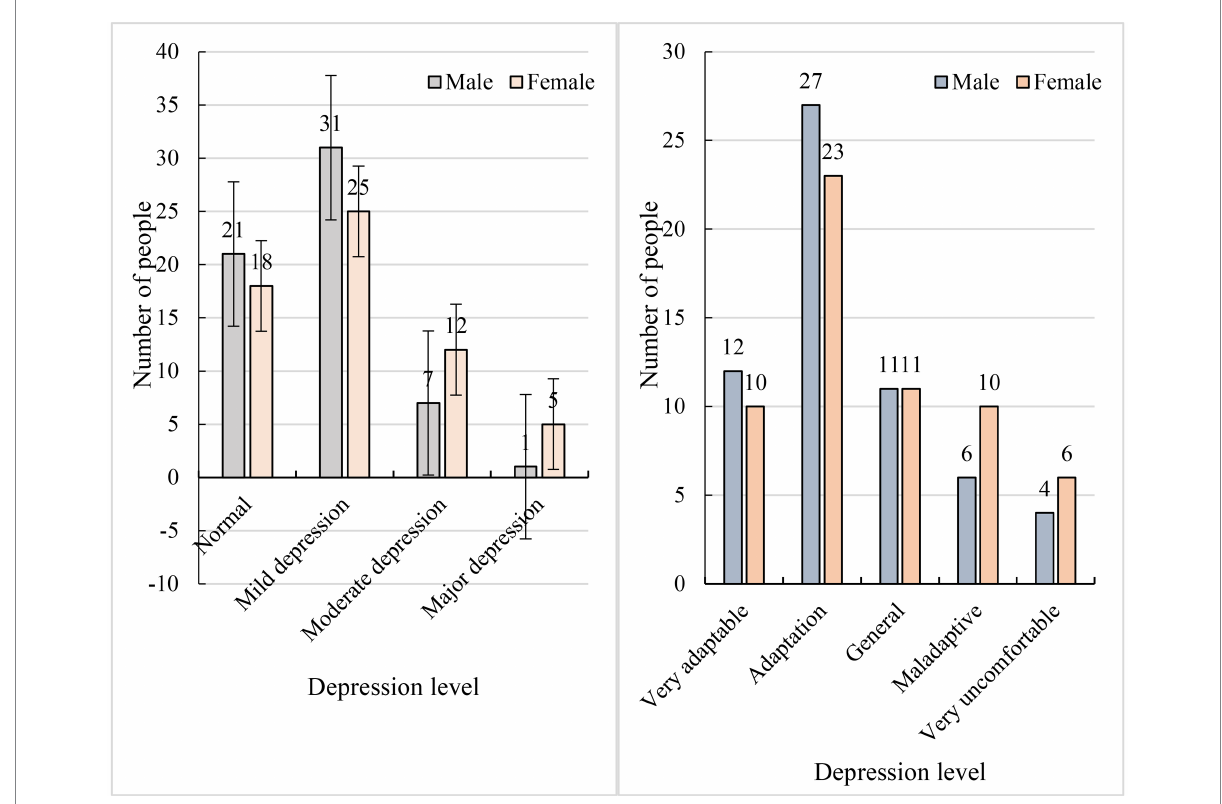
FIGURE 8 Psychological characteristics of international students and their adaptation to interpersonal